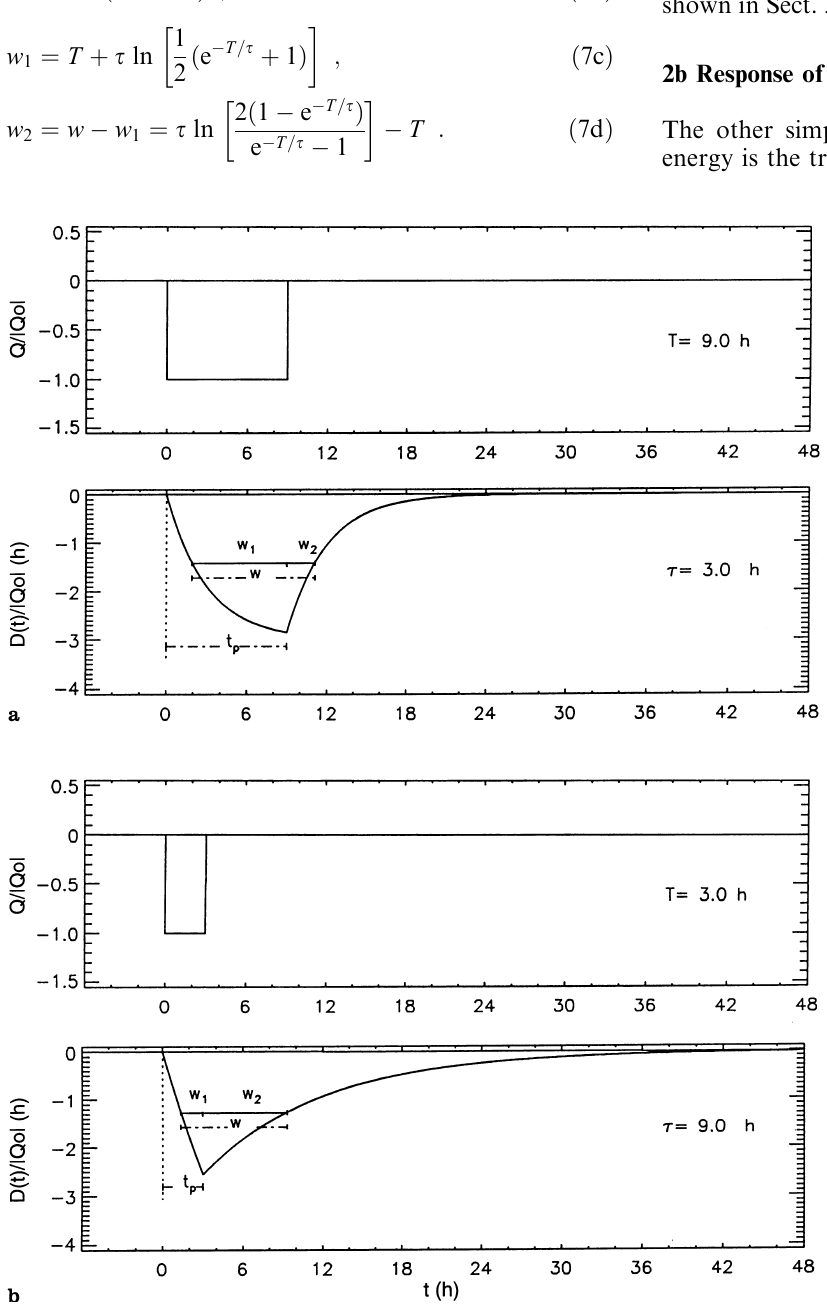
Fig. 1. a Behaviors of the rectangular normalized input function Q (cid:133) t (cid:134) = j Q o j ac- cording to Eq. (4) in the text ( upper panel ), and of the corresponding response func- tion D ( t ) also normalized in j Q o j according to Eq. (5a,b)( lower panel ). The adopted values of T and s are, respectively 9 and 3 h. The values of the characteristic times t p ; w ; w 1 and w 2 (see text), are also shown in the plot. b The same as a , except for T (cid:136) 3 h and s (cid:136)